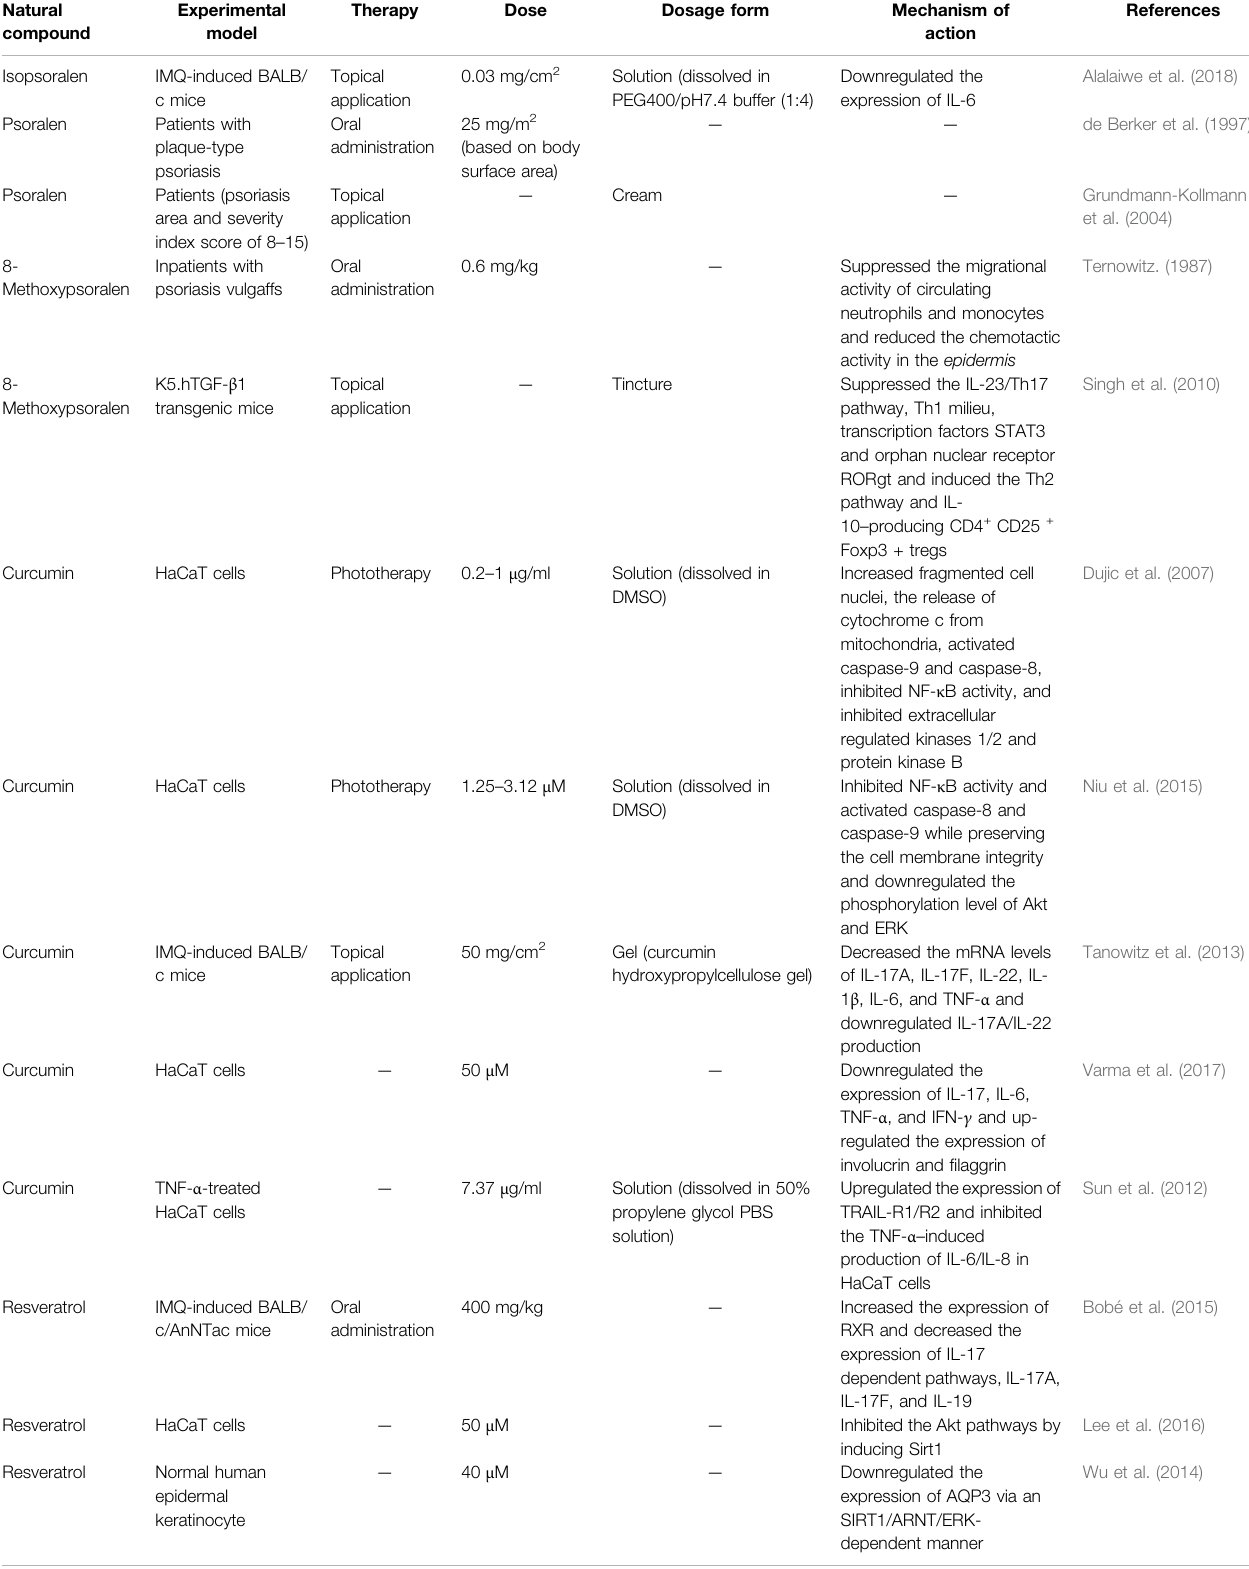
TABLE 2 | Phenylpropanoids for the treatment of